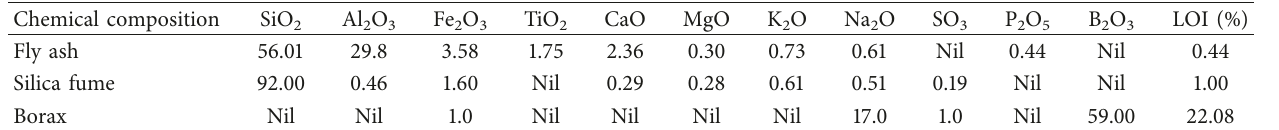
Figure 1: Scanning electron microscopic images of (a) fly ash, (b) silica fume, and (c) borax. Table 1: Chemical composition of different raw materials (quantity in %).